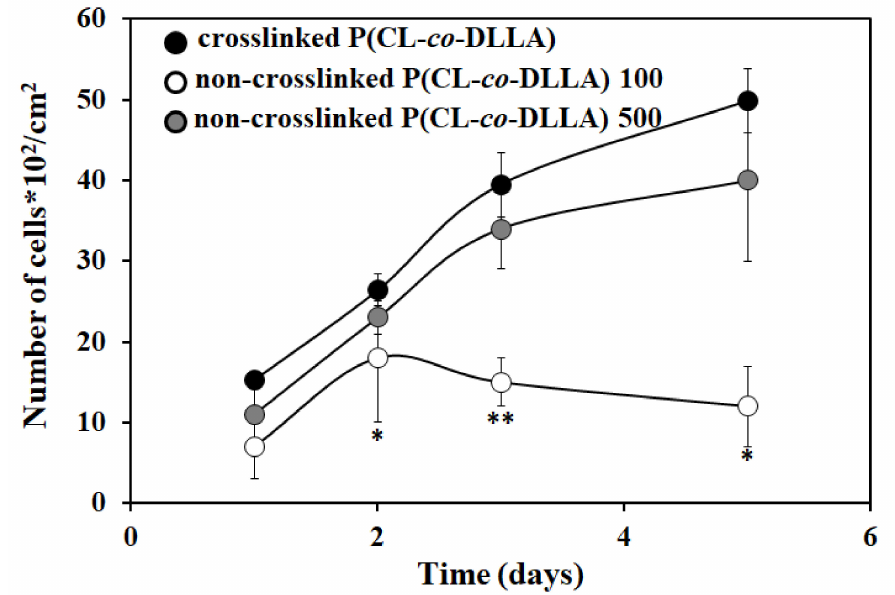
Figure 5. Proliferation behavior of MCF-7 cells on crosslinked P(CL- co -DLLA) non-crosslinked P(CL- co -DLLA) substrates at di ff erent time periods (1 day to 5 days). The cell proliferation increased by increasing the culture period on non-crosslinked P(CL- co -DLLA) 500 substrate. On non-crosslinked P(CL- co -DLLA) 100 substrates, initially the proliferation increased and later on the proliferation decreased. Each data represent n = 3 ± SD, where * p = 0.05 and ** p = 0.01 compared to crosslinked P(CL- co -DLLA)